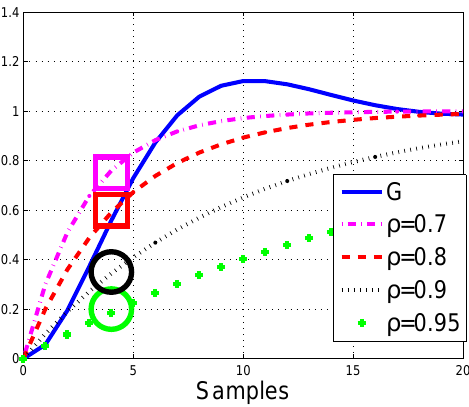
Figure 13. Open-loop step response of G coincidence points for an under-damped